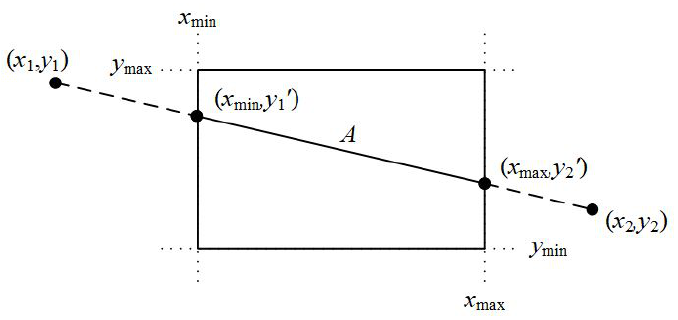
Figure 24. Selecting the points of the line that are inside the clipping